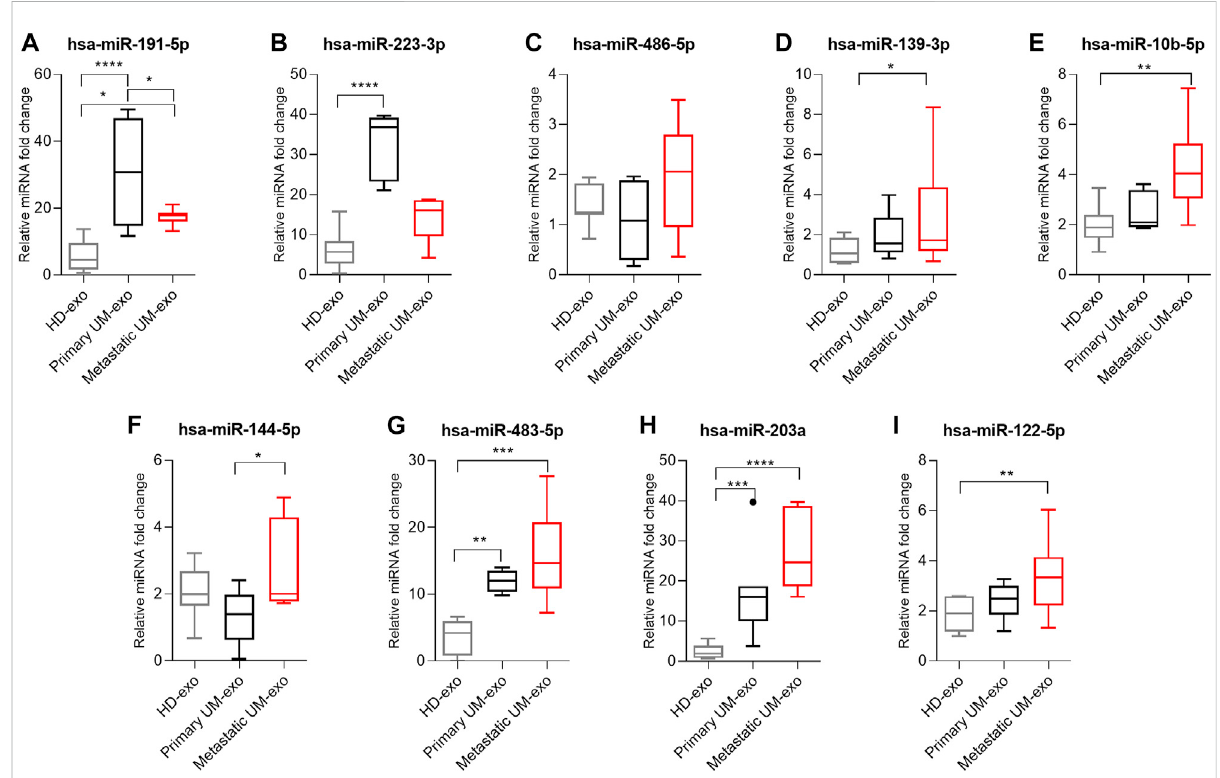
Real-time qPCR validation of hsa-miR-191-5p (A) , hsa-miR-223-3p (B) , hsa-miR-486-5p (C) , hsa-miR-139-3p (D) , hsa-miR-10b-5p (E) , hsa- miR-144-5p (F) , hsa-miR-483-5p (G) , hsa-miR-203a (H) , hsa-miR-122-5p (I) in exosomes derived from healthy donors (HD-exo, n=20), patients with primary (primary UM-exo, n = 9) and metastatic disease (Metastatic UM-exo, n = 11). The results are displayed as relative miRNA fold change calculated as log2- ΔΔ Ct. Data was normalized to exogenous spike-in: hsa-miR-6351-5p mimic. The graph represents median ±SD, outliners are marked as dots. The statistical differences between the two groups were analyzed with Two-way ANOVA or Kruskal-Wallis test with Dunn ’ s post hoc multiple comparison test, where: * p < 0.05, ** p < 0.01, *** p < 0.001, **** p <